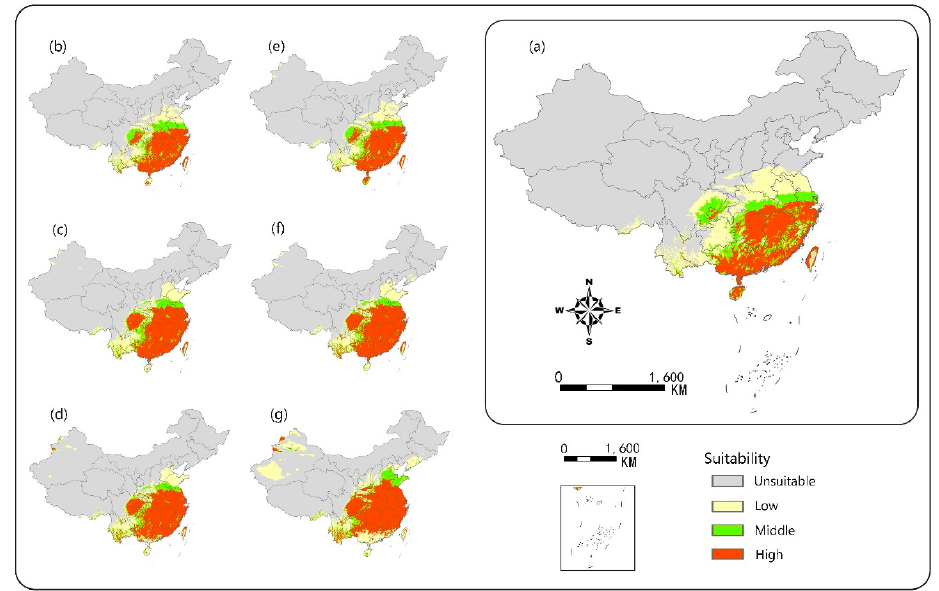
Figure 4. Potential habitat suitability of camphor tree projected by MaxEnt model. ( a ) Current occurrence; ( b ) based on RCP4.5 in 2025s; ( c ) based on RCP4.5 in 2055s; ( d ) based on RCP4.5 in 2085s; ( e ) based on RCP8.5 in 2025s; ( f ) based on RCP8.5 in 2055s; ( g ) based on RCP8.5 in 2085s.